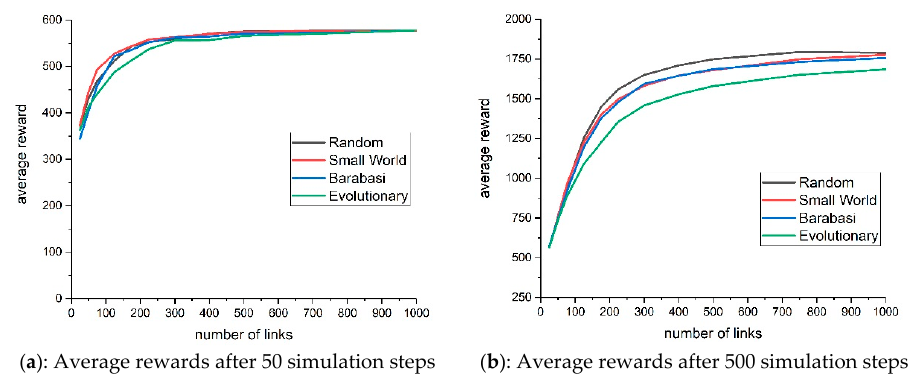
Figure 4. Average rewards of firms for different networks.